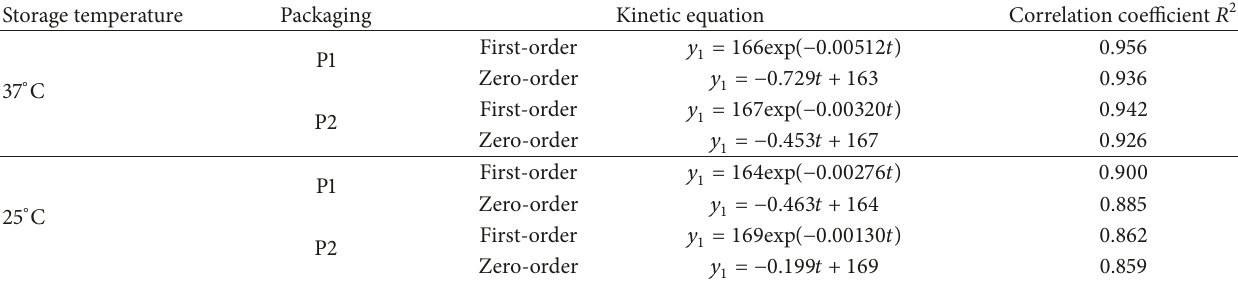
Table 1: Kinetic equation of lycopene in THPS during storage.